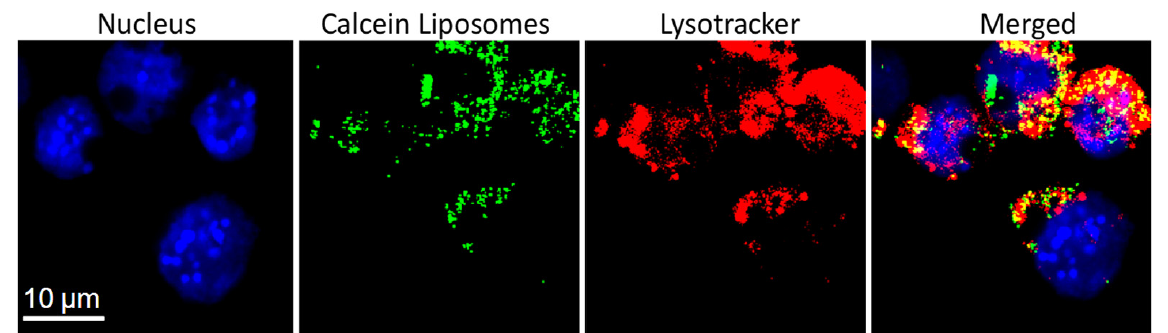
Figure 15. Fluorescence intensity resulting from the intracellular distribution of calcein containing gold-coated liposomes following incubation with RAW 264.7 model macrophage cells. The punctate nature of the calcein fluorescence is consistent with localization of the liposomes in endosomes. This is confirmed by labeling late endosomes and lysosomes with LysoTracker Red DND-99. The merged images shows that the calcein and LysoTracker fluorescence co-localize, confirming that the liposomes are located in the endosomes. Adapted from [47], published by Wiley, 2020.